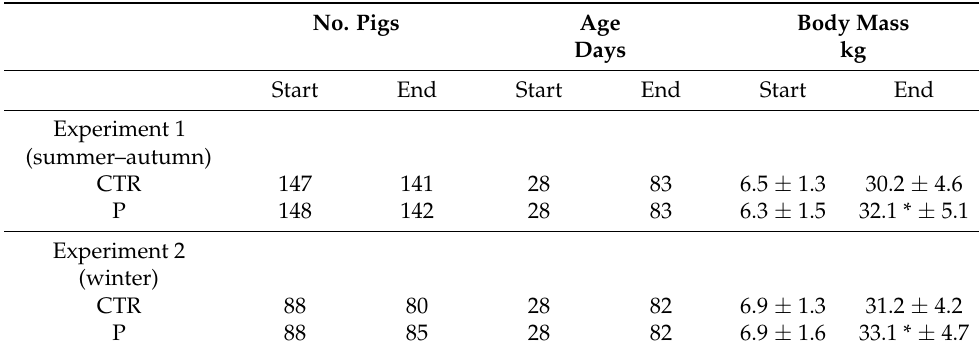
Table 1. Description of the piglet groups in the two compartments CTR and P, during the two analysed growing periods. No. Pigs Age Body Mass Days